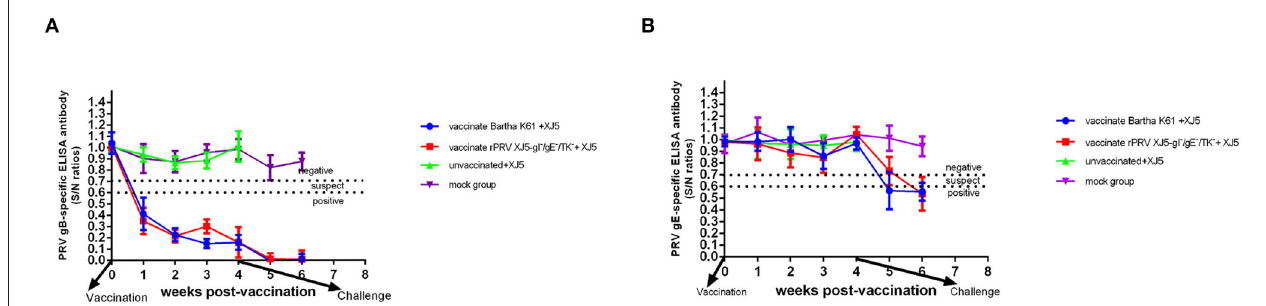
FIGURE 1 | Anti-PRV sero-conversion of pigs before and after challenge; commercial ELISA kits were used to detect the anti-PRV gB antibody (A) and the anti-PRV gE antibody (B) . The dashed line indicates the cutoff value. S/N ratio = sample OD 650nm divided by negative control OD 650nm ; S/N < 0.6, positive; 0.6 < S/N ≤ 0.7, suspect; S/N > 0.7,